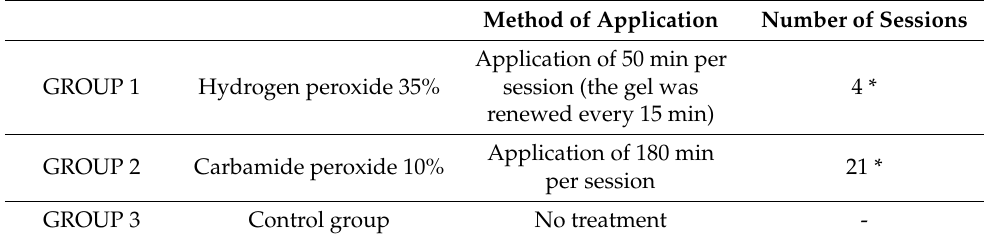
Table 1. Treatment groups (in-situ zymography).